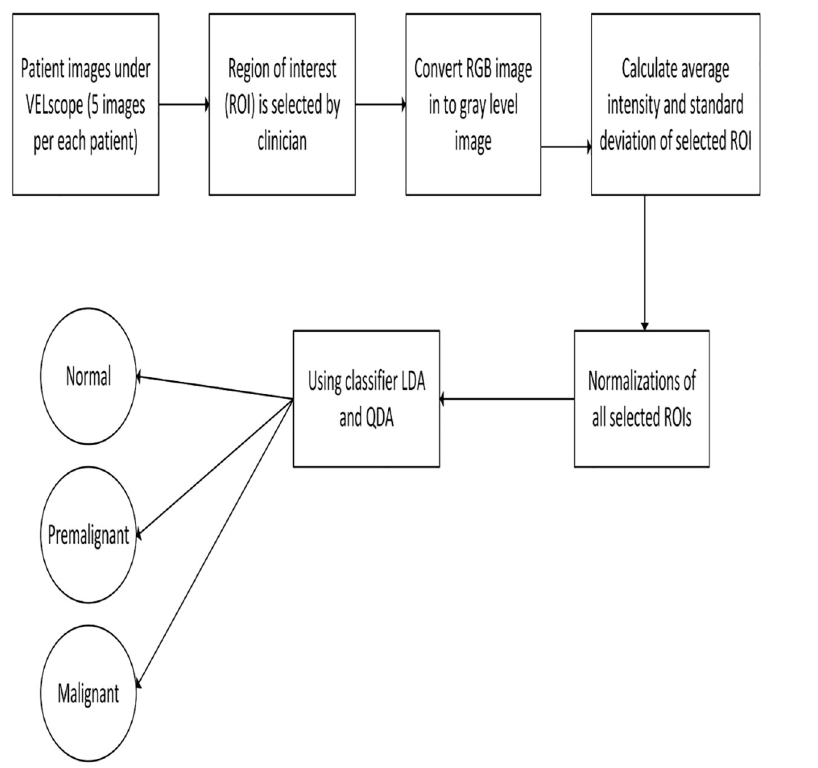
Fig 2. Block diagram of proposed